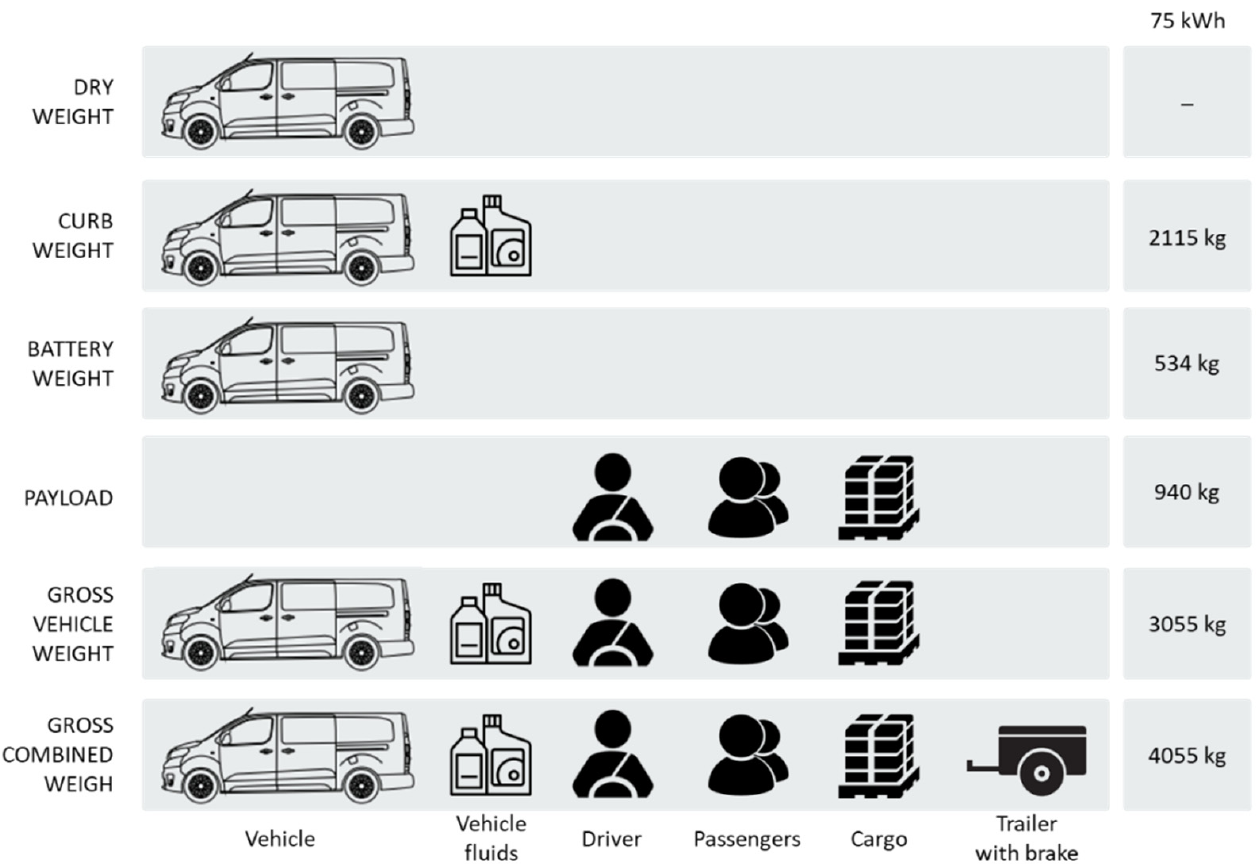
Figure 7. Mass limits of the tested vehicle (values read from the registration certificate of used in research vehicle) based on [32].